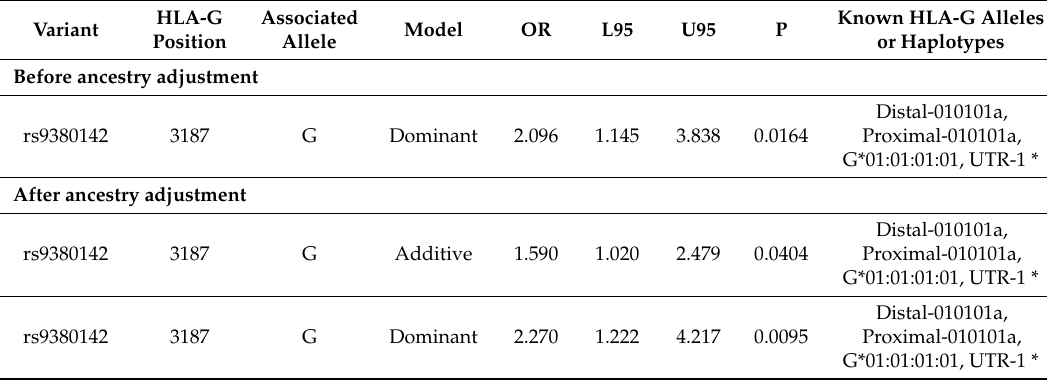
Figure 1. Genomic ancestry distribution in a Brazilian population sample composed of vitiligo patients and healthy controls. This triangular plot was generated by the Structure software, and the corners correspond to parental populations: Africans (AFR), East Asians (EAS), and Europeans (EUR). Yellow (healthy controls) and pink (vitiligo patients) dots correspond to Brazilian individuals, while blue, green, and red dots represent Africans, Europeans, and East Asians, respectively. Table 1. Sites associated with vitiligo detected in a Brazilian sample.